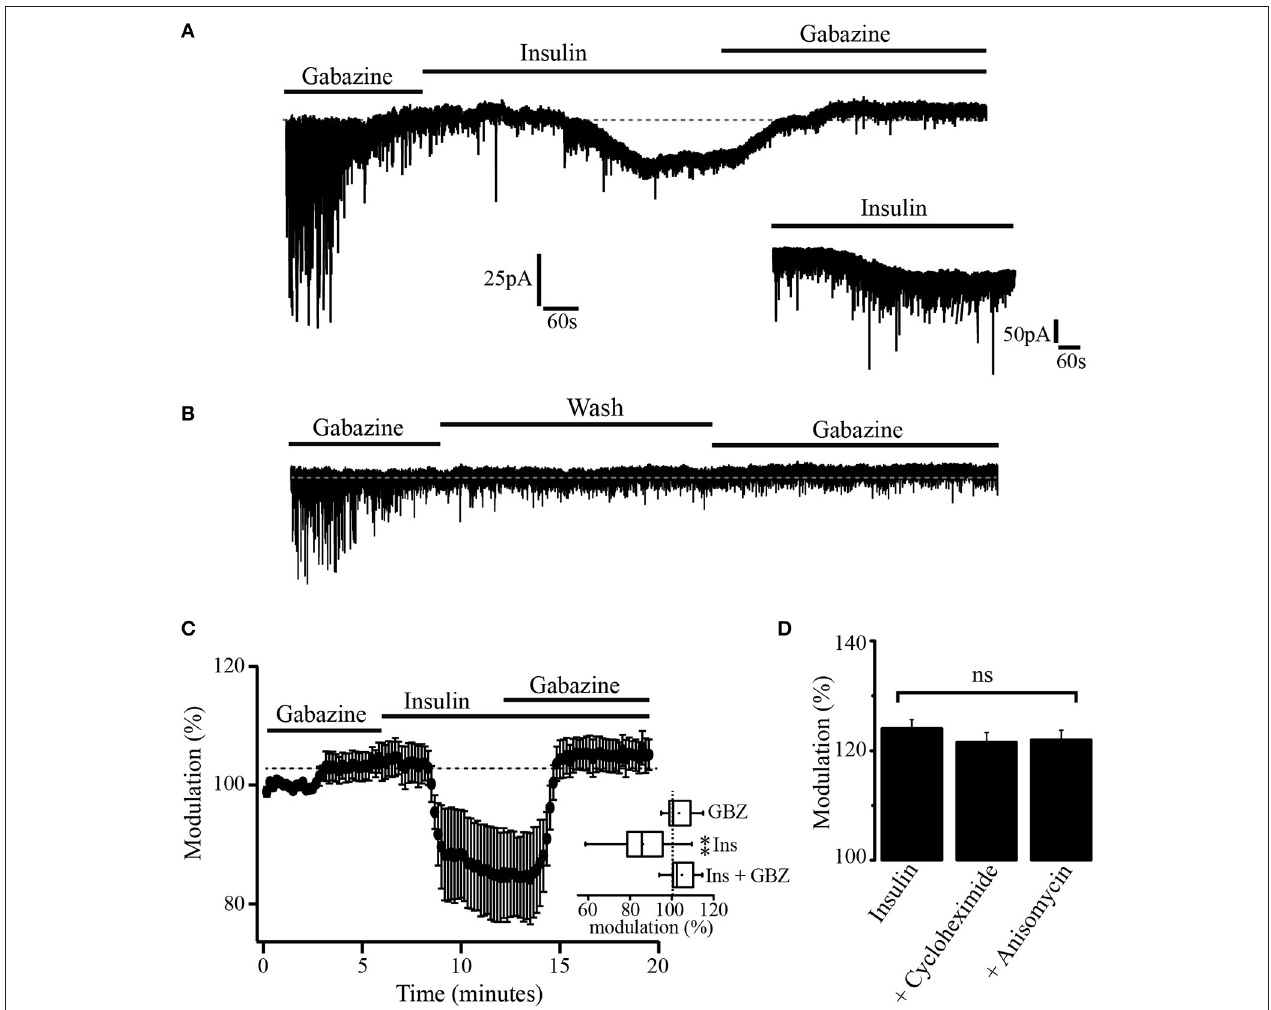
FIGURE 4 | Insulin promotes GABA A mediated tonic current. (A) After the blockage of GABA A receptors with gabazine, insulin (500nM) produced a downward shift of the holding current. This effect was reversed by a new application of gabazine. The inset is a 10min current trace showing the effect of insulin alone. (B) When insulin was replaced by the vehicle (wash) a new administration of gabazine was without effect ( n = 5). (C) Graph showing the shift of the tonic current produced by insulin normalized with respect to the effect of gabazine alone ( n = 7). The inset shows a box plot graph comparing insulin and insulin plus gabazine (GBZ) vs. gabazine alone. (D) Bar plots comparing the normalized shift of the holding current by gabazine in cells from slices incubated with insulin alone ( n = 5), insulin plus cycloheximide ( n = 5), and insulin plus anisomycin ( n = 5). Changes were not statistically significant (ns) ** p <